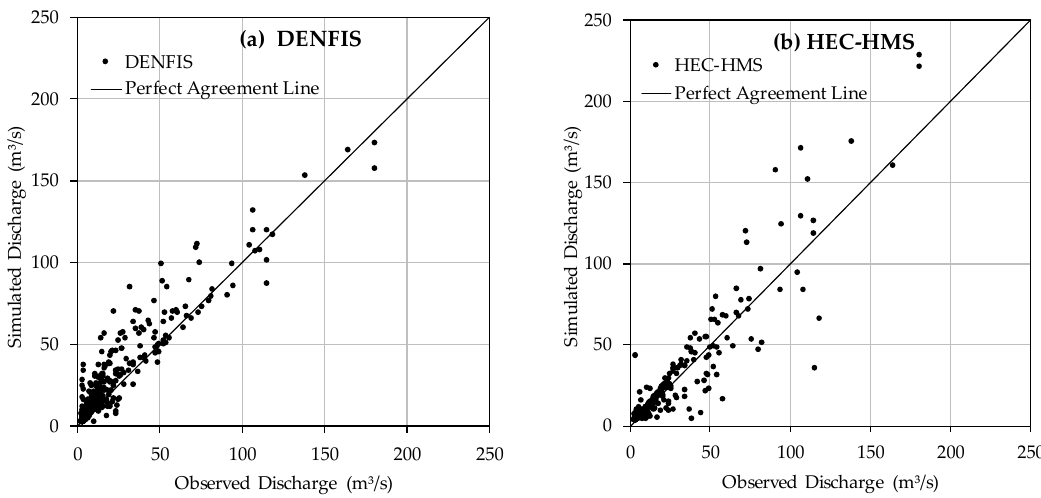
Figure 6. Observed versus simulated discharge for 18 testing events in Sungai Kayu Ara catchment obtained by: ( a ) DENFIS and ( b ) HEC–HMS.